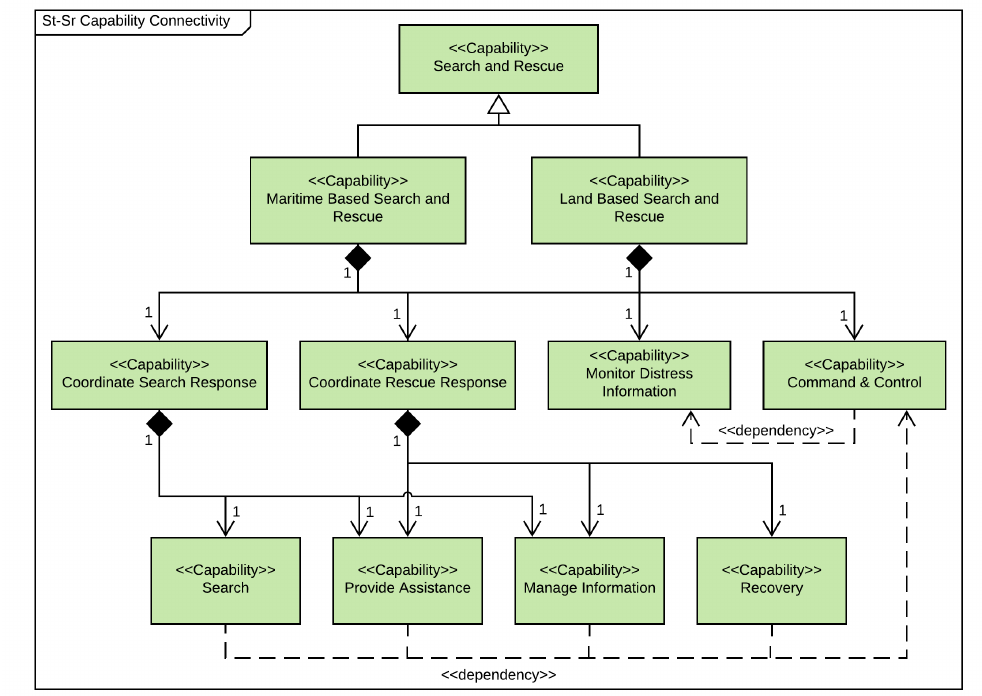
Figure 7. An example of a Strategic Structure (St-Sr) view of the Unified Architecture Framework (UAF) that describes the capability connectivity of the overall search and rescue (SAR)